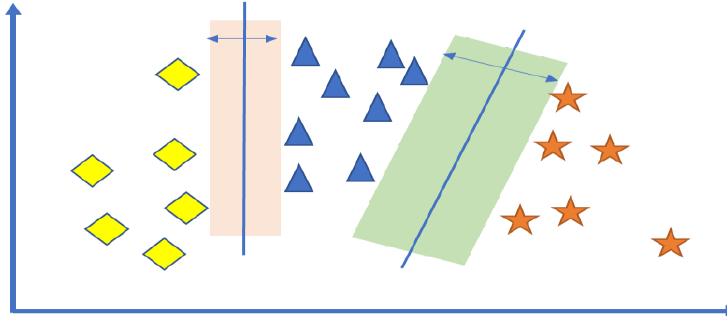
Figure 1. A typical SVM model classifying three types of data.